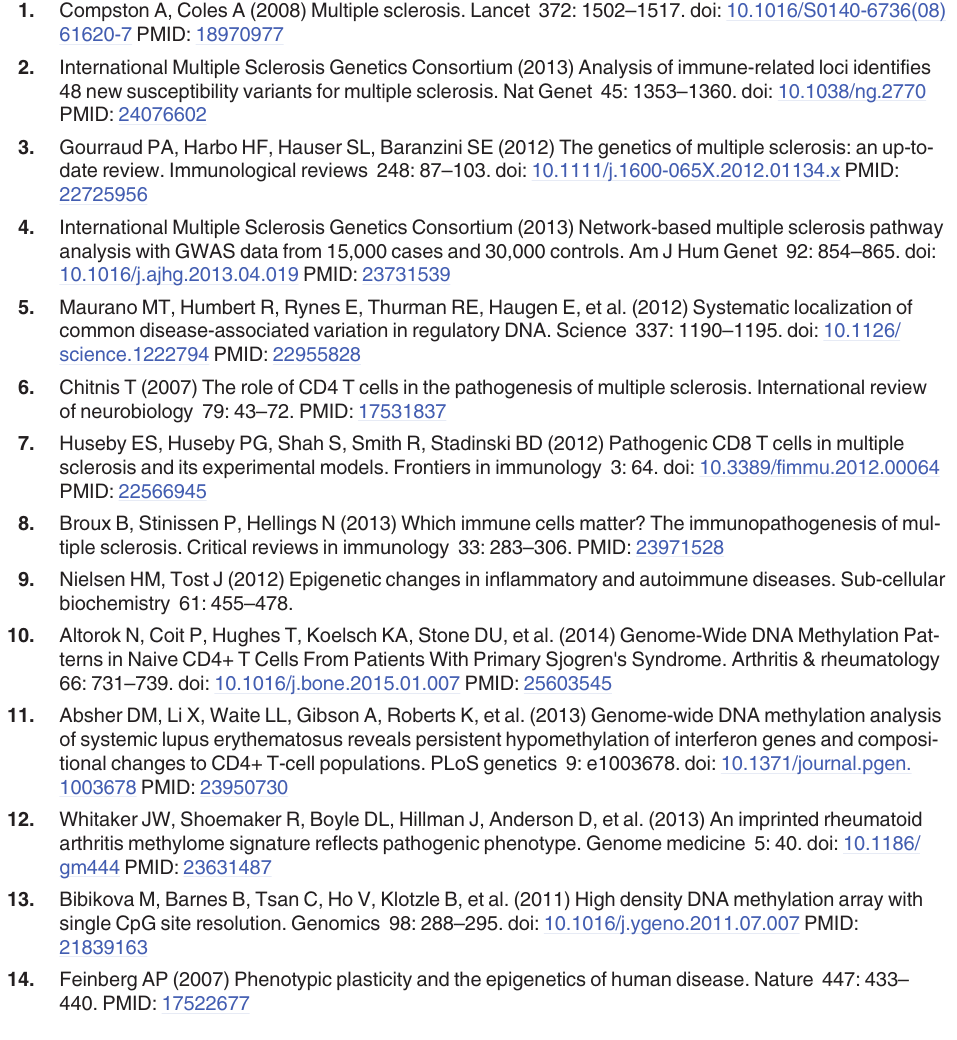
S3 Table. Per-gene analyses